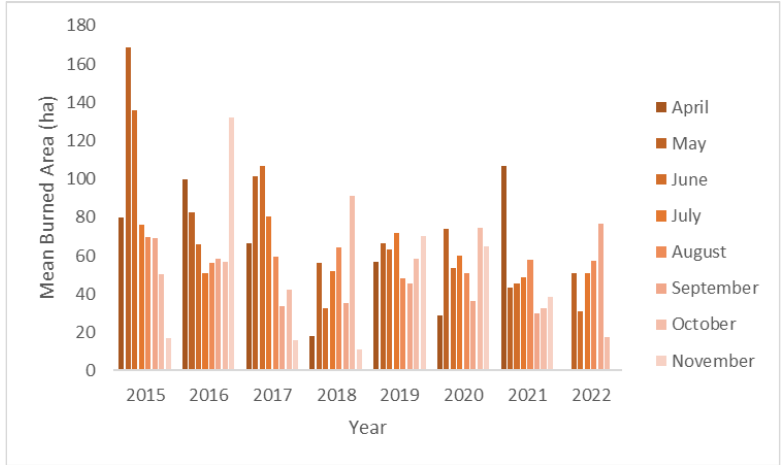
Figure 11. Mean burned area by month and year.